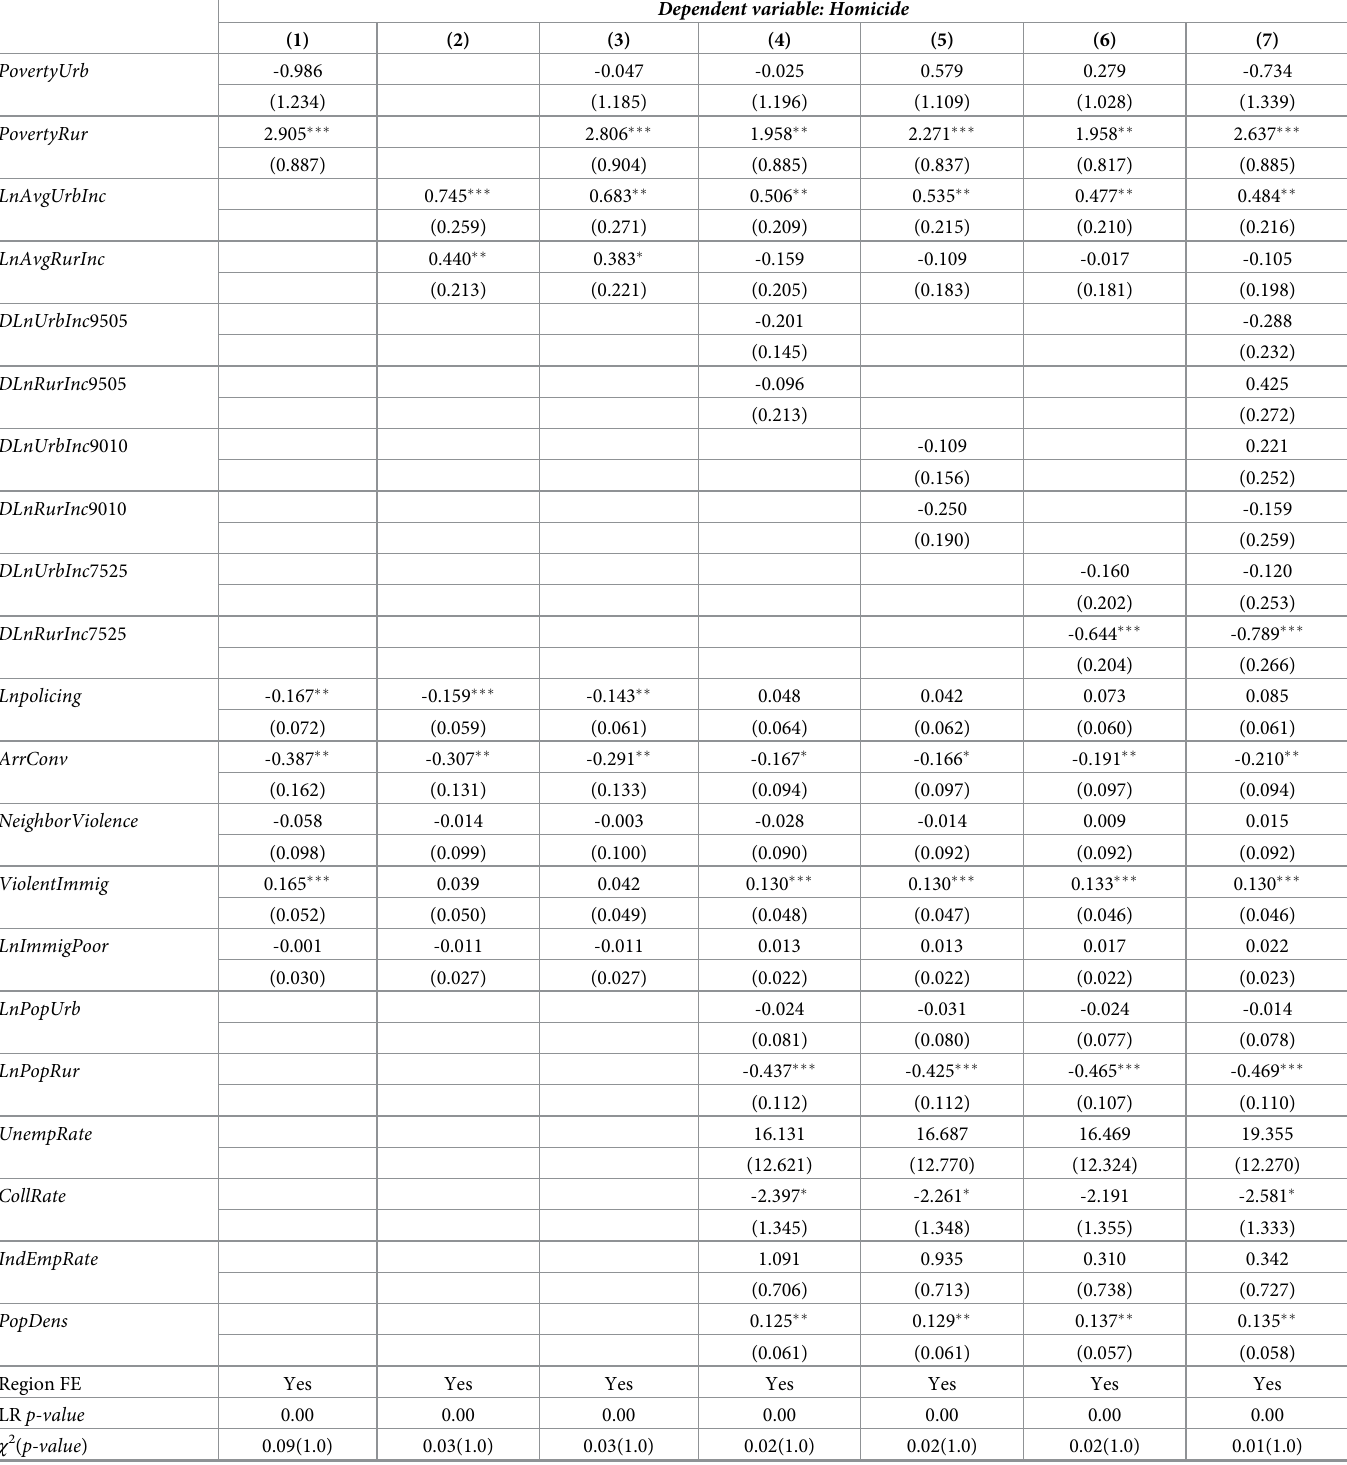
Table 4. The effect of poverty level and income inequality in rural and urban